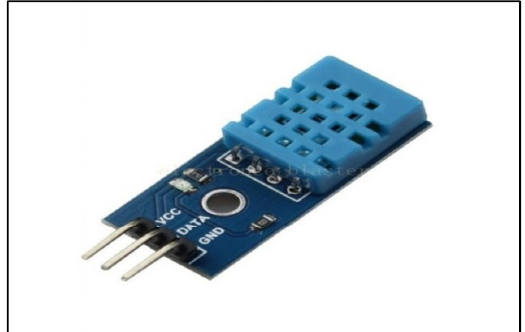
Fig. 3. DHT Sensor.